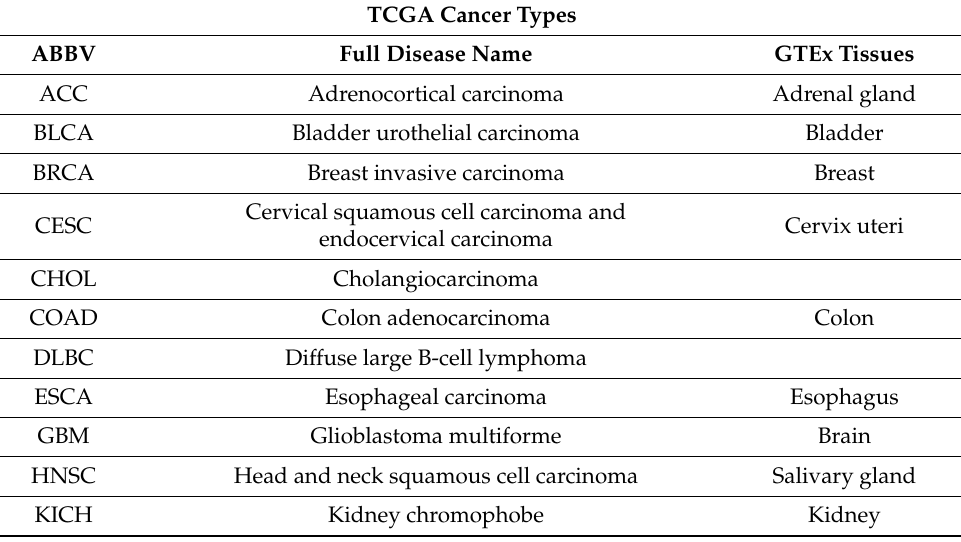
Table 1. TCGA study names. Table of the diseases studied in the TCGA project, including disease abbreviations and full disease names. Tissues studied in the GTEx project that directly correlate with TCGA disease locations are also